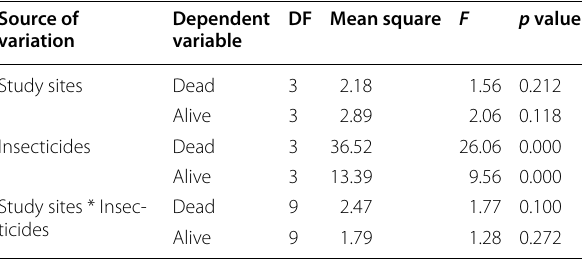
Fig. 2 Percent of dead and resistant mosquitoes across the study areas